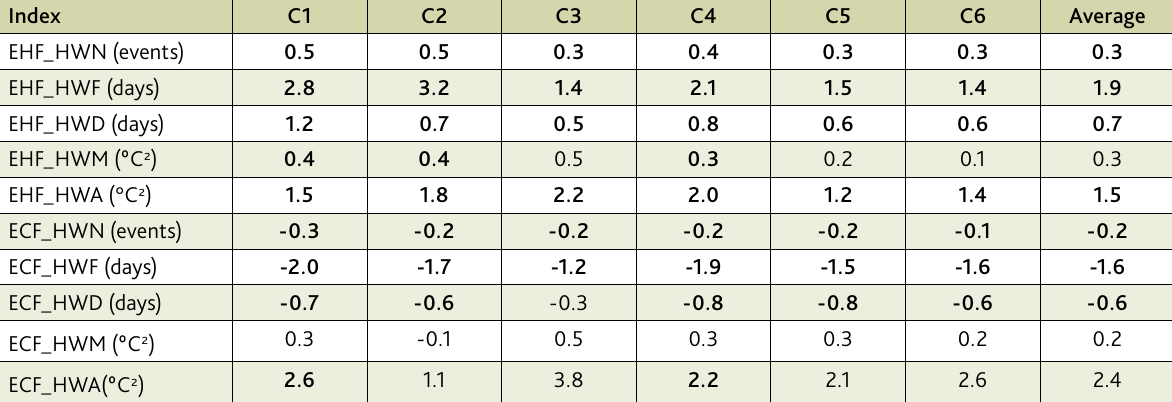
Table 5. Temporal trends (/10 yrs) of the ET-SCI HW and CW indices for the climate regions defined by cluster, in the period 1950-2018. In bold, confidence level <